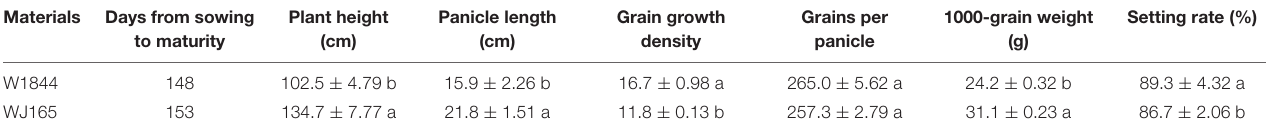
TABLE 1 | Agronomic traits of the japonica rice materials. Materials Days from sowing Plant height Panicle length to maturity (cm)